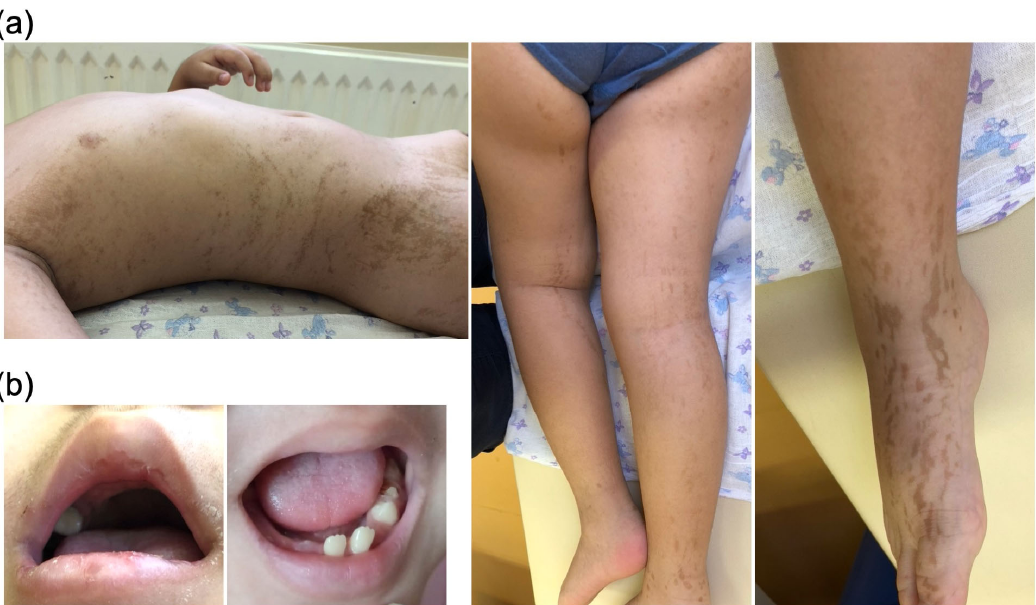
Figure 2. Atypical findings of MPS II found in the proband. ( a ) Skin linear hyperpigmented streaks along Blaschko’s lines. ( b ) Anodontia and small teeth.